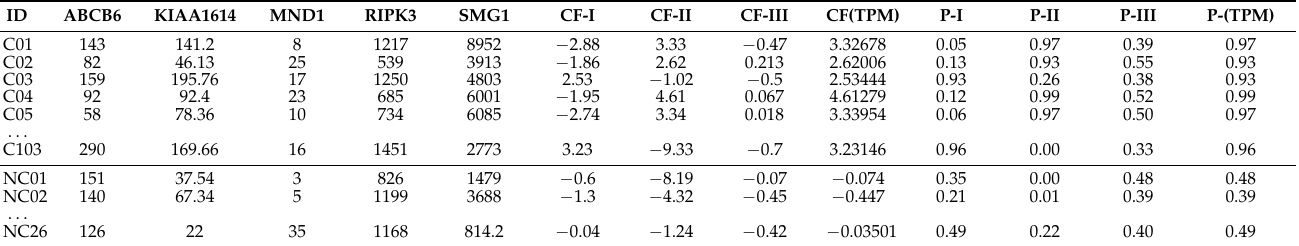
Table 3. EC data: Expression values of the five critical genes, competing classifier factors, and predicted